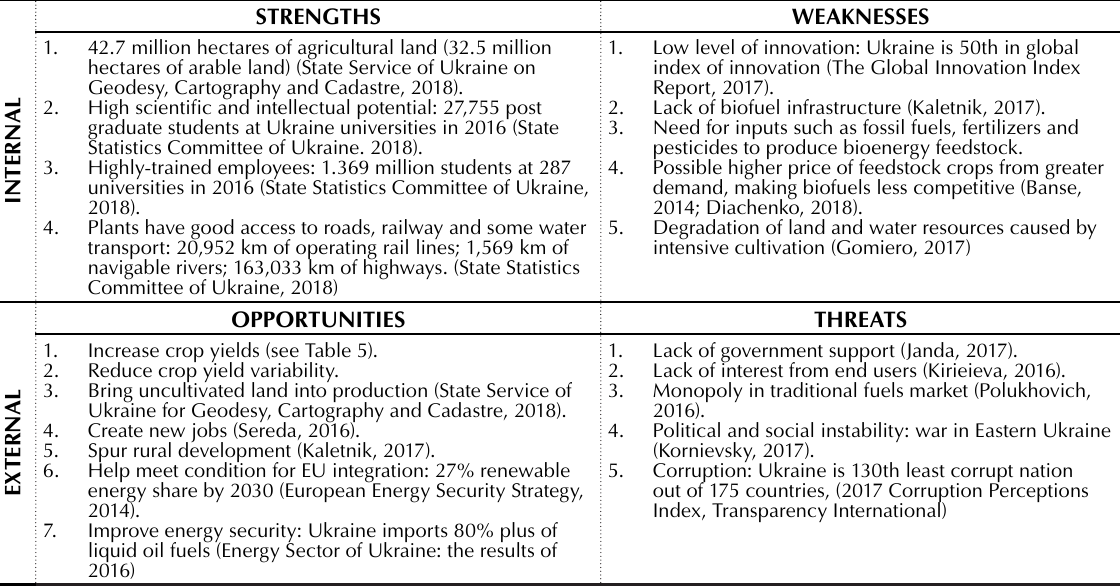
Source: Developed by the authors.